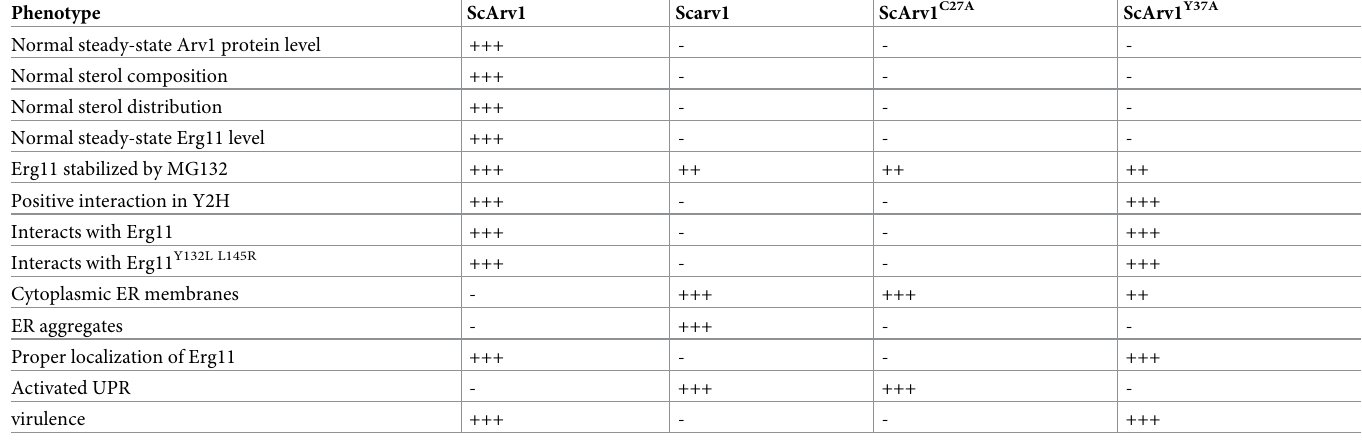
Table 3. Phenotypes of Arv1